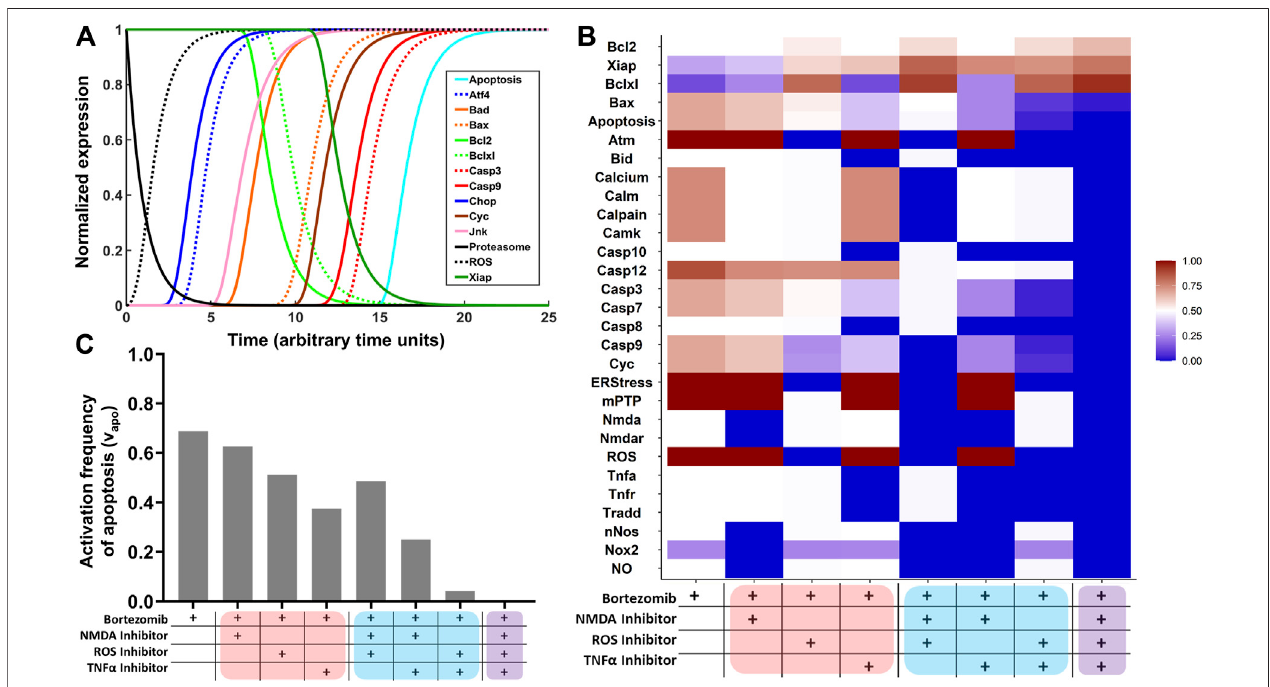
FIGURE 1 | Network simulations to identify combinatorial treatment strategies for BIPN. (A) Network model simulations of select intracellular components in the presence of proteasome inhibition. The Boolean network model was converted to normalized HillCube differential equations using Odefy , and default parameter values wereused(tau (cid:1) 1; k (cid:1) 0.5; n (cid:1) 3).Simulationswereperformedfor25-timesteps(arbitraryunits).Resultsfromattractoranalysisfortherelativeactivationfrequencyof (B) network nodes and (C) neuronal apoptosis across identi fi ed attractors for eight network perturbations: proteasome inhibition (bortezomib) in combination with